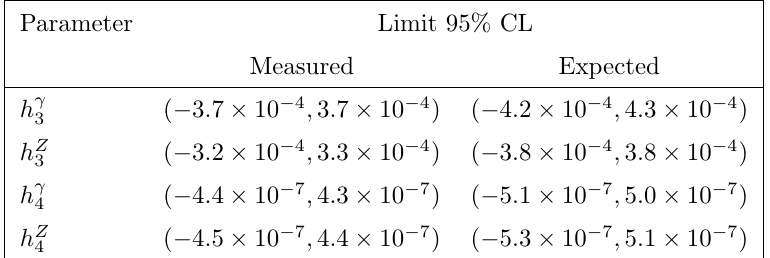
Table 8 . Observed and expected one-dimensional 95% CL limits on h (cid:13) that any observed excess in data relative to the associated SM estimate is due solely to h V For each row, all parameters other than the one under study are set to 0.